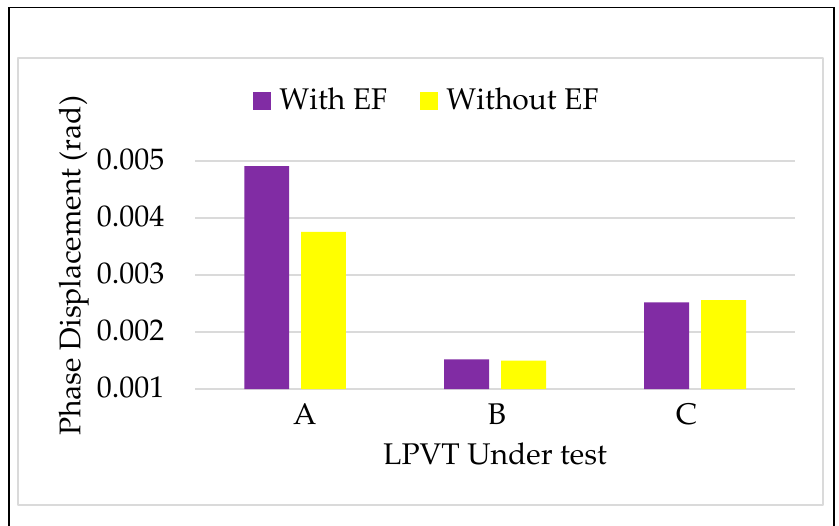
Figure 8. Phase displacement vs. electric field for the three LPVTs under test.